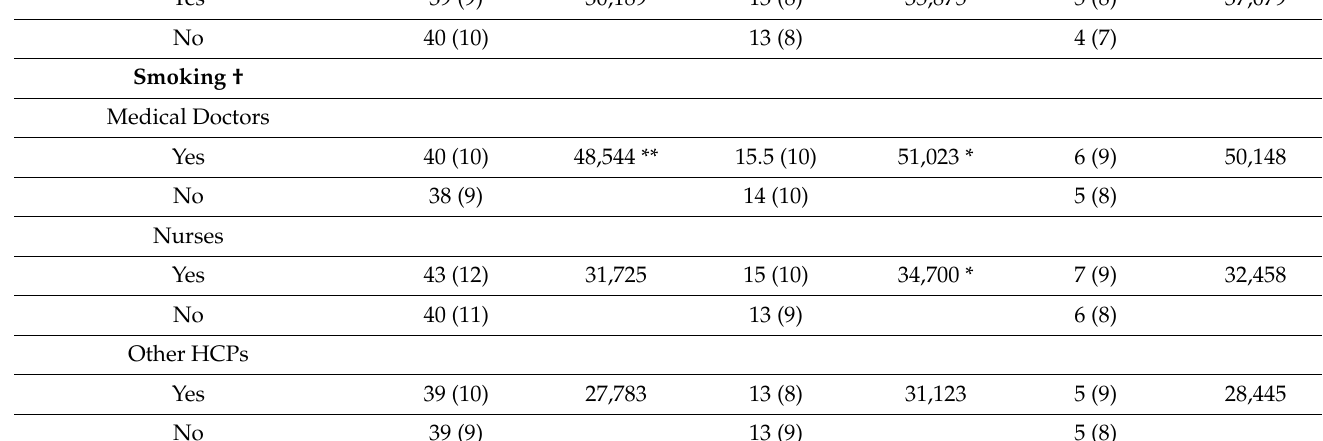
Table 4. Difference in mental health scales between various sociodemographic and addiction related variables. Sociodemographic